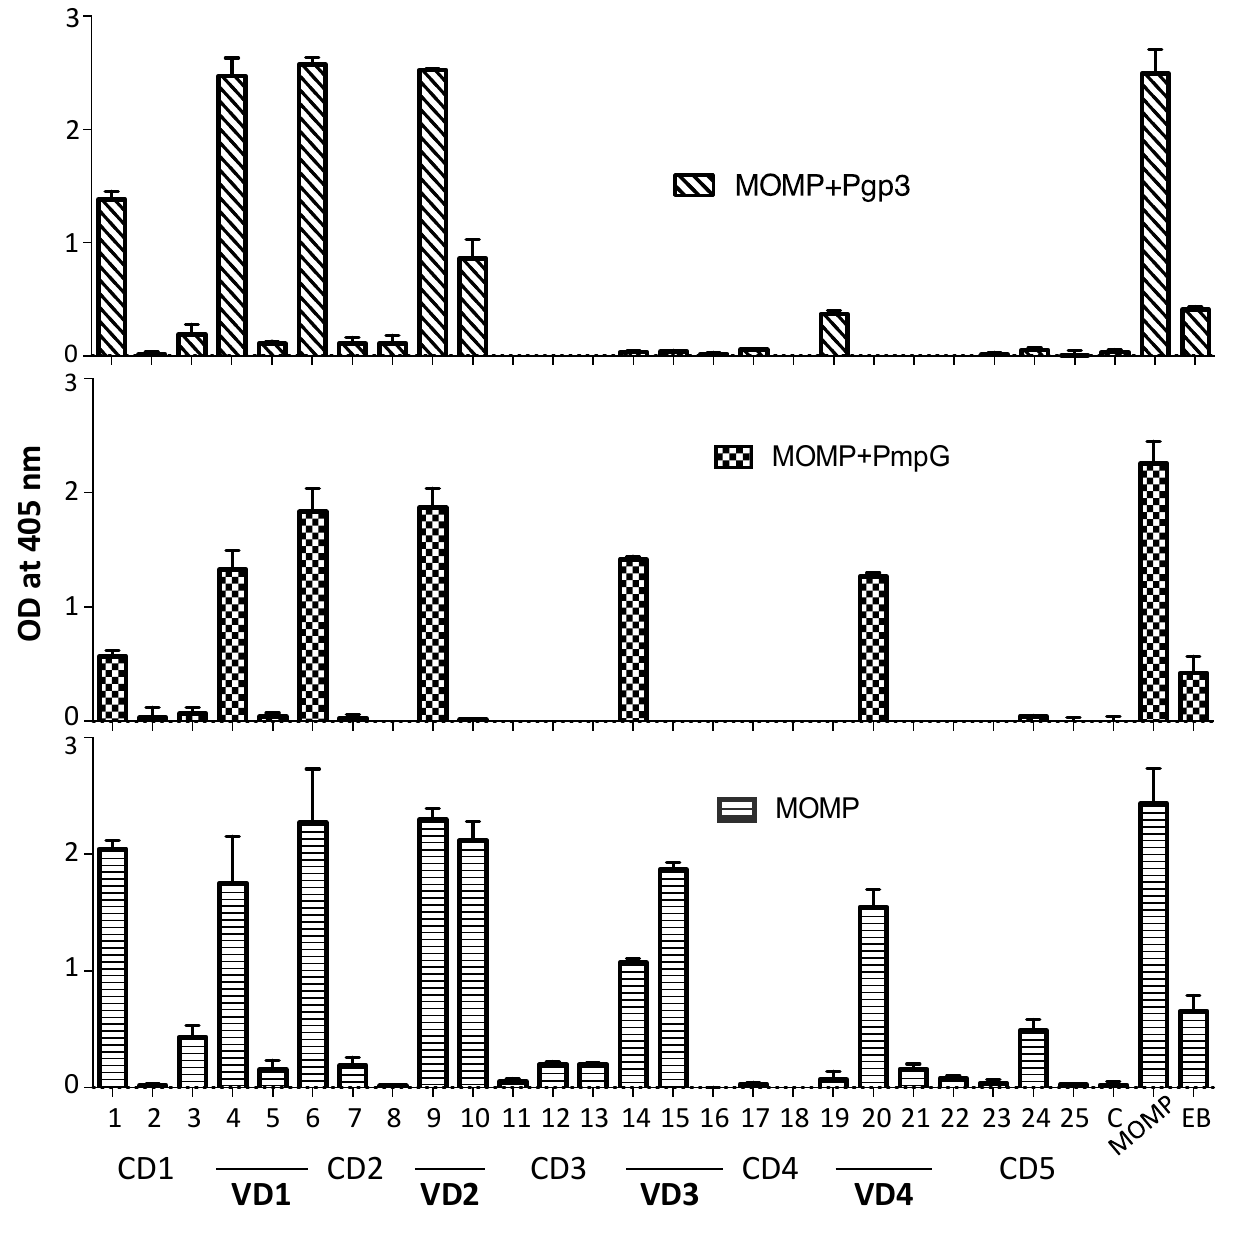
Figure 4. Detection of serum antibodies specific for C. muridarum MOMP peptides (OD 405 ± SD). Serum samples from immunized mice were collected the day before the i.n. challenge and their reactivity to 25-mer overlapping peptides corresponding to the whole amino acid sequence of mature C. muridarum MOMP were analyzed by ELISA. MOMP and C. muridarum EB were used as positive